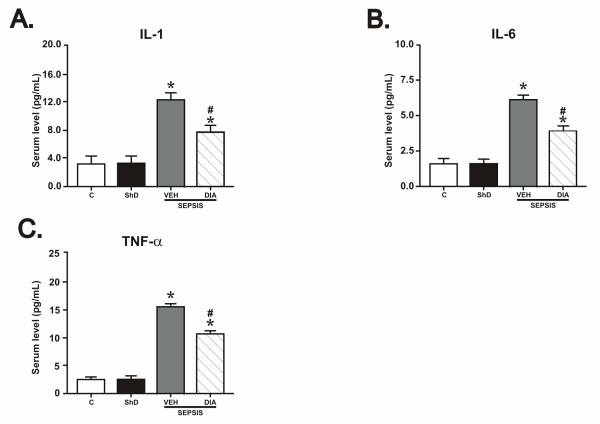
Serum levels of IL-6 (A), IL-6 (B), and TNF-α (C). Data are presented as mean and SD of six to eight rats per group. *P < 0.05 versus Sham/Vehicle; #P < 0.05 (Sepsis/Veh versus Sepsis/Dia). C, Sham/Vehicle; ShD, Sham/Diacerhein; VEH, Sepsis/Vehicle; DIA, Sepsis/Diacerhein. Representative blots show total and insulin-induced protein expression.